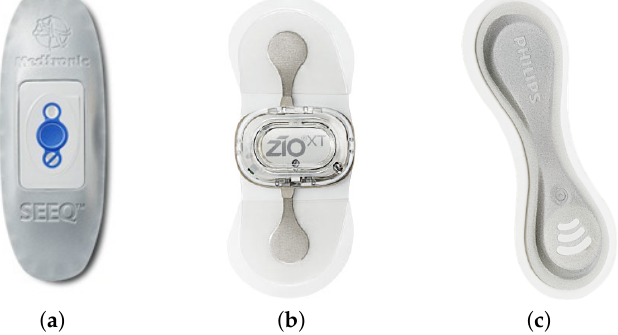
Figure 5. ( a ) SEEQ TM sensor by Medtronic, Inc.; ( b ) ZIO R (cid:13) XT Patch by iRhythm Technologies, Inc.; ( c ) Philips